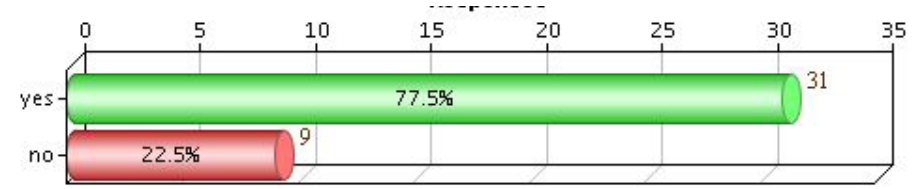
Figure 9 . Did you use a mobile device to access MobiMOOC course materials? ( N =